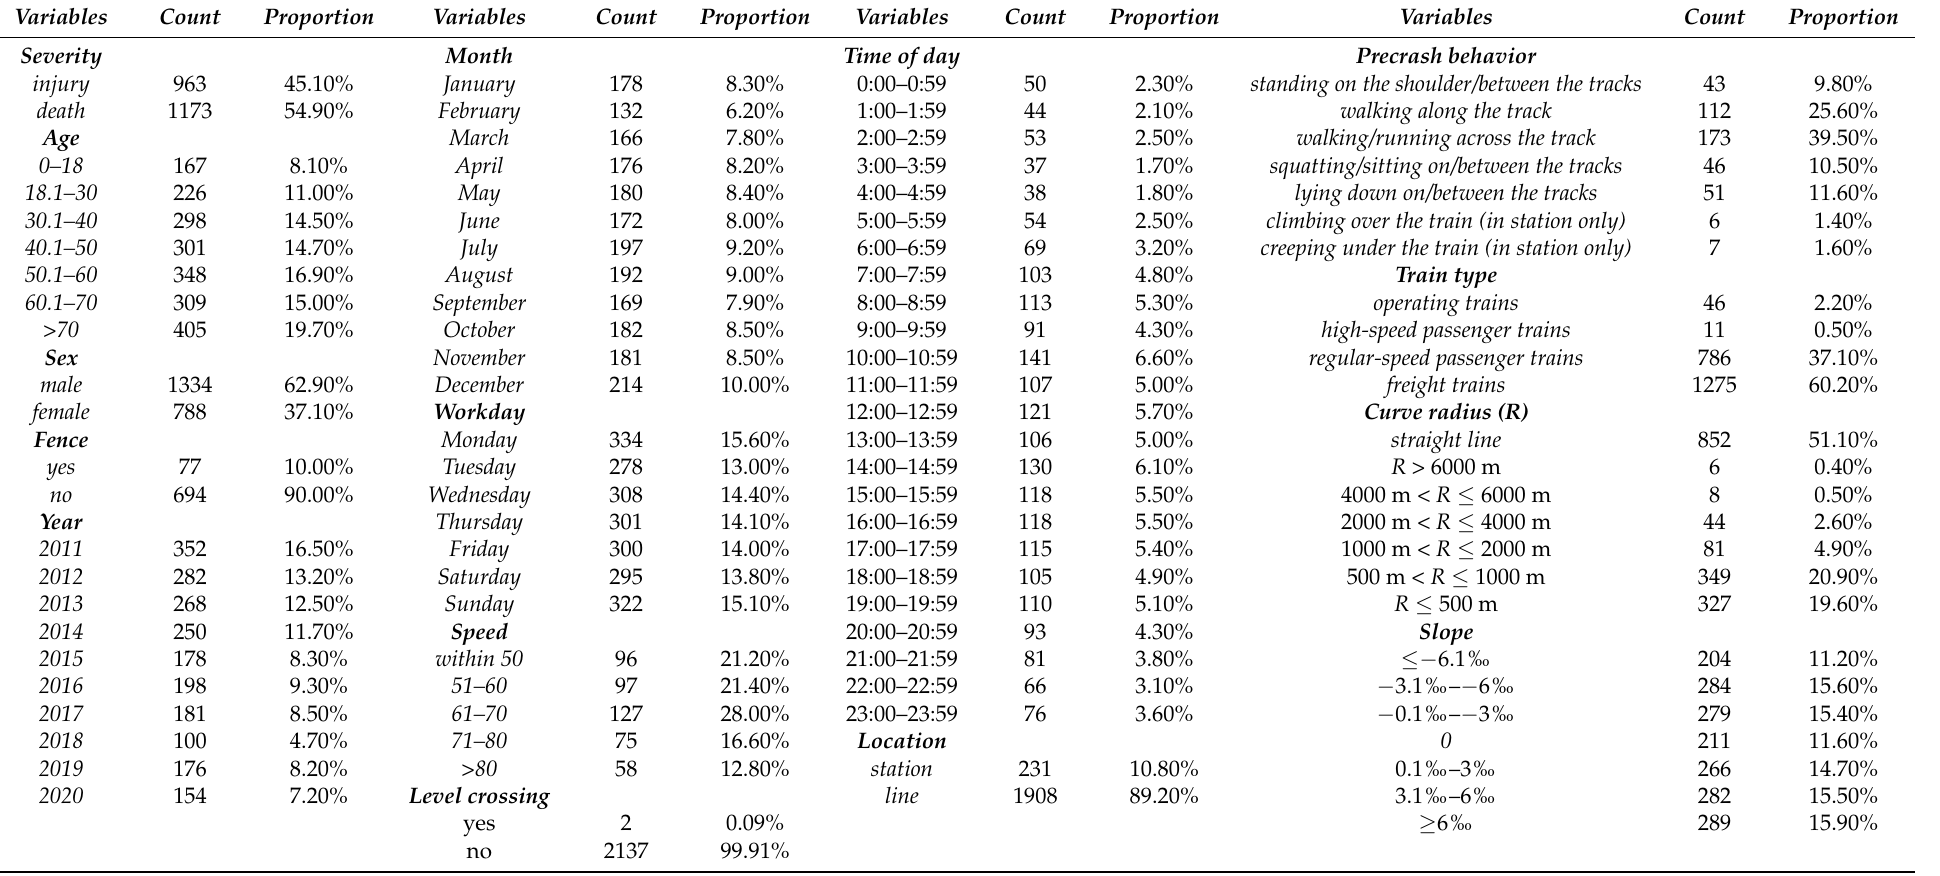
Table 4. Statistical results of all single